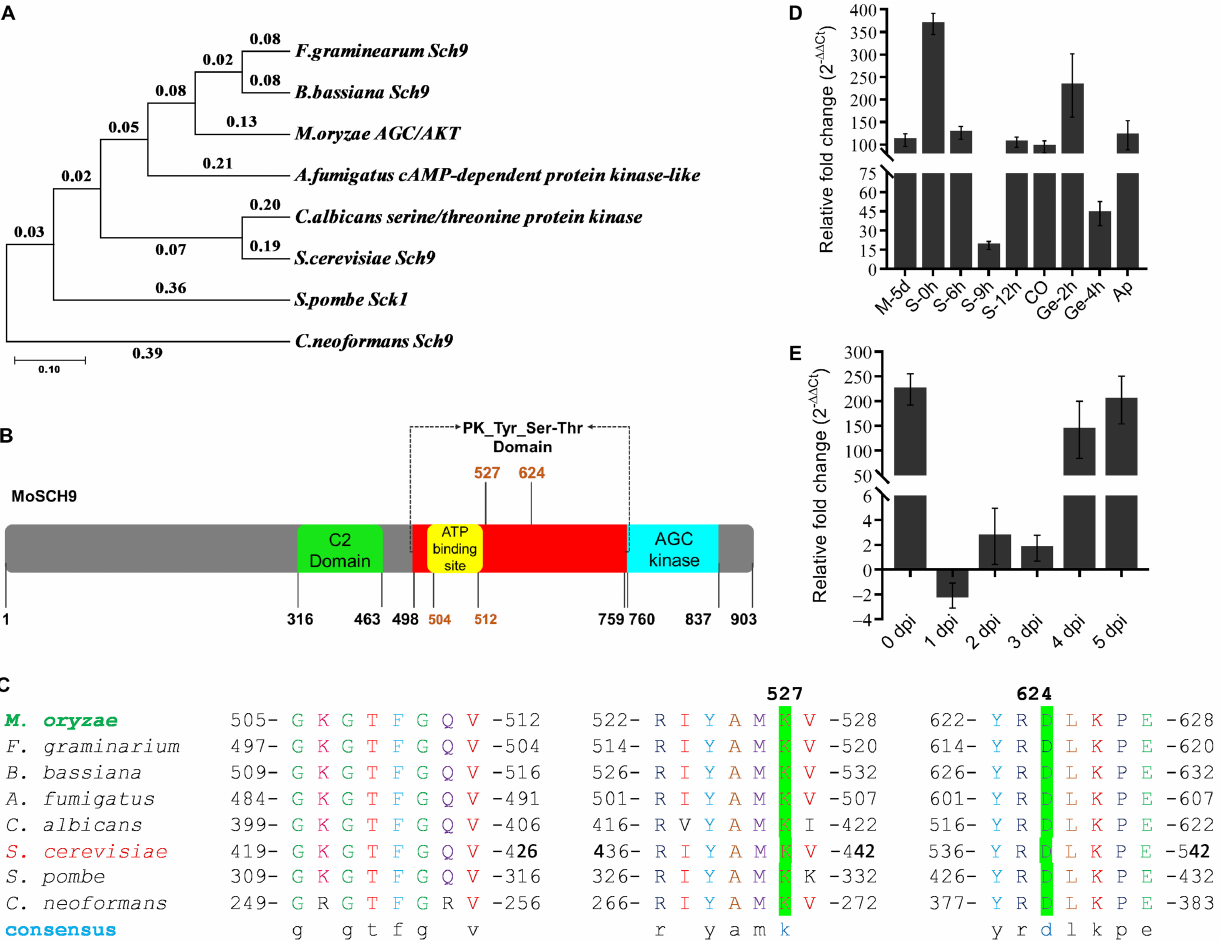
Figure 1. Phylogenetic assessment, protein structure, domain alignment, and expression of AGC/AKT protein kinase MoSch9 in Magnaporthe oryzae . ( A ) Maximum likelihood phylogeny constructed with Sch9 proteins homologs across different fungal species including Fusarium grami- narium , Beauveria bassiana , Magnaporthe oryzae , Aspergillus fumigatus , Candida albicans , Saccharomyces cerevisiae , Saccharomyces pombe , and Cryptococcus neoformans . ( B ) MoSch9 protein structure. MoSch9 is a serine/threonine protein kinase. ( C ) Sequence alignment showing highly conserved ATP binding and active site in reported fungi. ( D ) Expression of MoSch9 at different growth phases of M. oryzae . For M, RBM; S, conidiophores stalks formation; Co, conidia; Ge, germination; Ap, appressoria. Vegetative hyphae on 5 day old CM were used as a control stage and assumed as unity (expression level of MoSch9 at hyphal stage on CM = 1). ( E ) Expression pattern of MoSch9 at different stages of infection development of M. oryzae in rice. Error bars indicate the means ± SD calculated from three independent technical replicates in which triplicate biological samples for each strain were examined in each